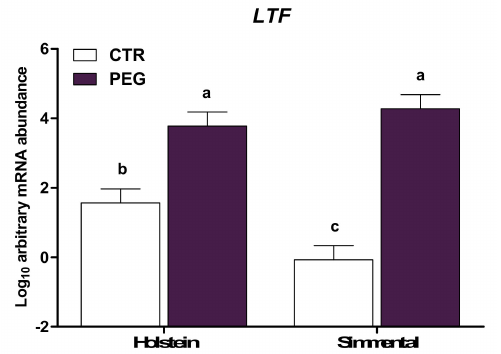
Figure 4. LSM ± SEM of Log10 arbitrary mRNA abundance for gene expression of LTF (lactotransferrin) evaluated three days after calving in Simmental and Holstein cows treated either with pegbovigrastim (PEG) or with saline (CTR) at approximately Day 7 relative to calving and on the day of calving within 24 h. Di ff erent letters represent significant di ff erences among groups at p ≤ 0.05.